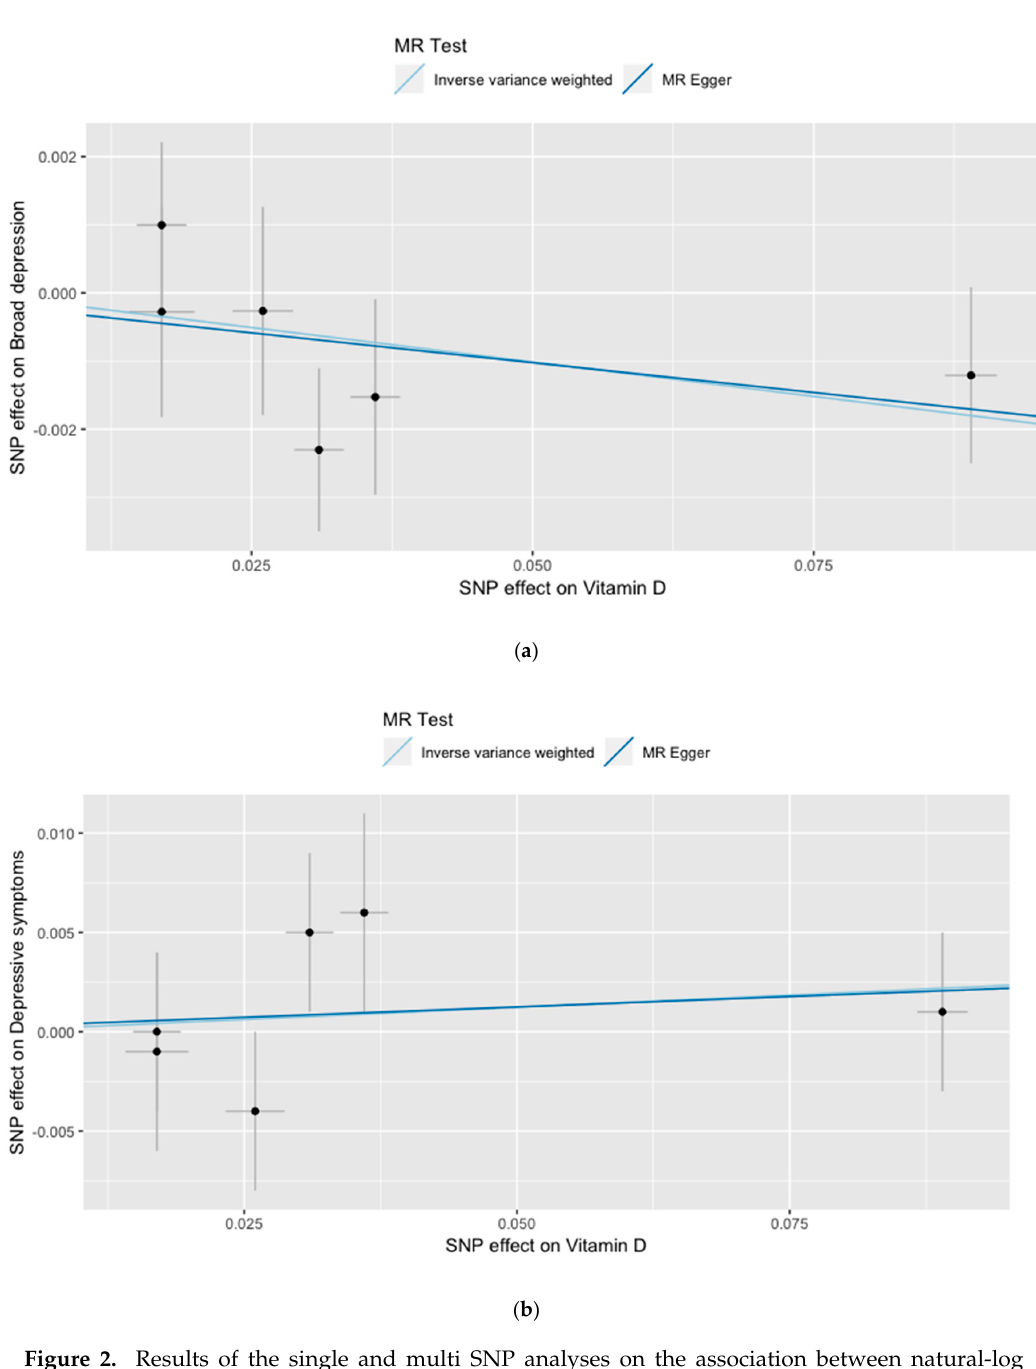
Figure 2. Results of the single and multi SNP analyses on the association between natural-log transformed 25(OH)vitamin D concentration and ( a ) broad depression and ( b ) depressive symptoms. A SNP effect of 0.025 means that carrying an alternative allele at this SNP was associated with an expected increase in the natural-log transformed 25(OH)D by 0.025; e^(beta) gives the change in 25(OH)vitamin D in percentage. Accordingly, a SNP effect of 0.025 was associated with an expected increase of 25(OH)D by 2.5% (e^0.025 = 1.025), while a SNP effect of 0.1 was associated with an expected increase of 25(OH)D by 10.5% (e^0.1 = 1.105).